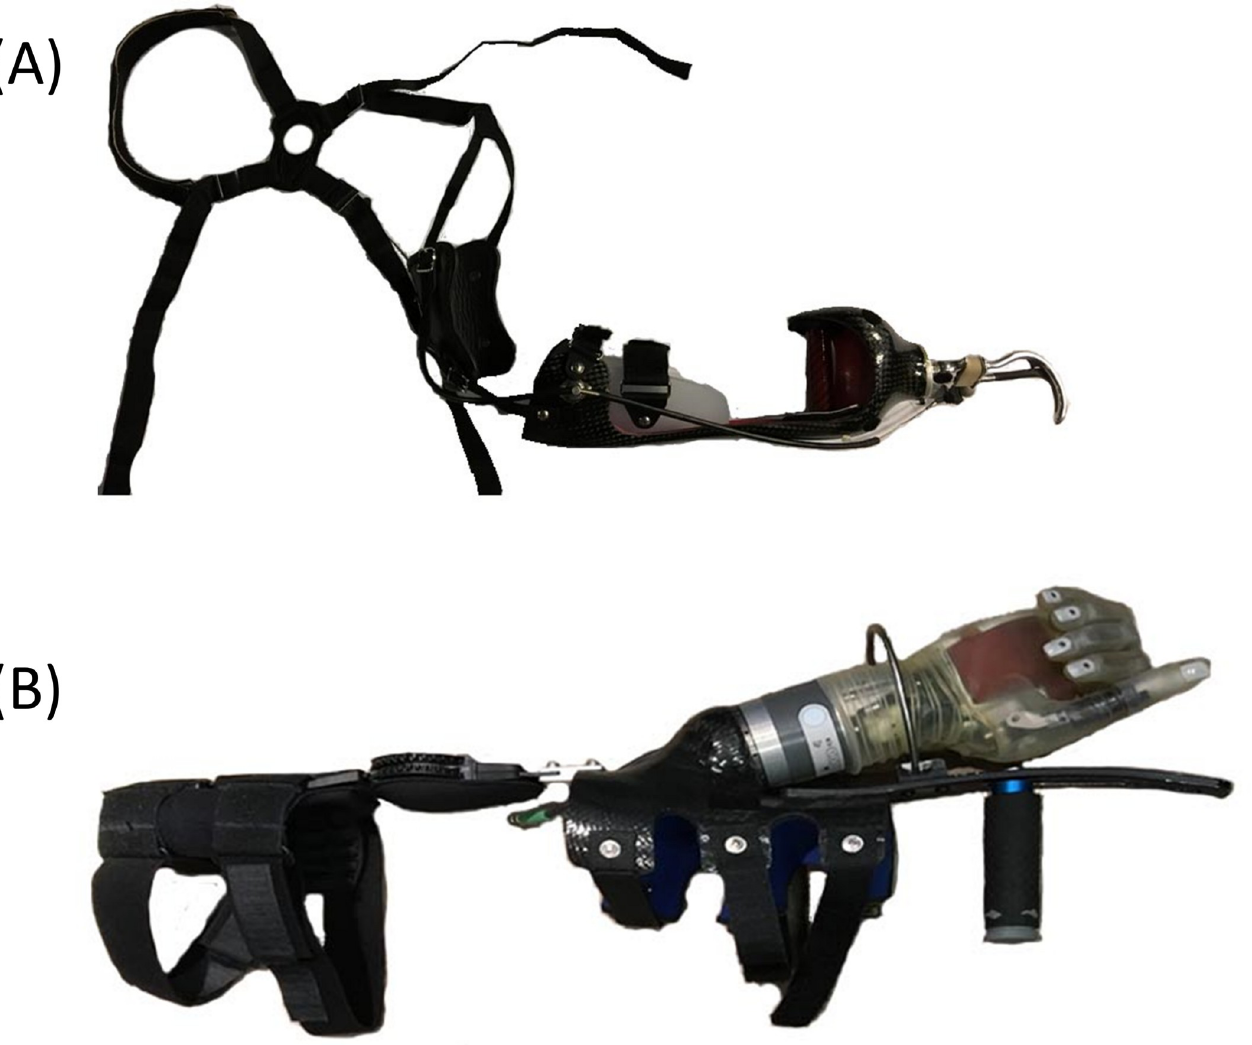
Fig 1. Upper limb prosthesis bypass devices. A) Body Powered Bypass device, right side configuration with body-powered voluntary open Hosmer 5x split hook terminal device. B) DEKA Bypass device, right-hand radial configuration with powered